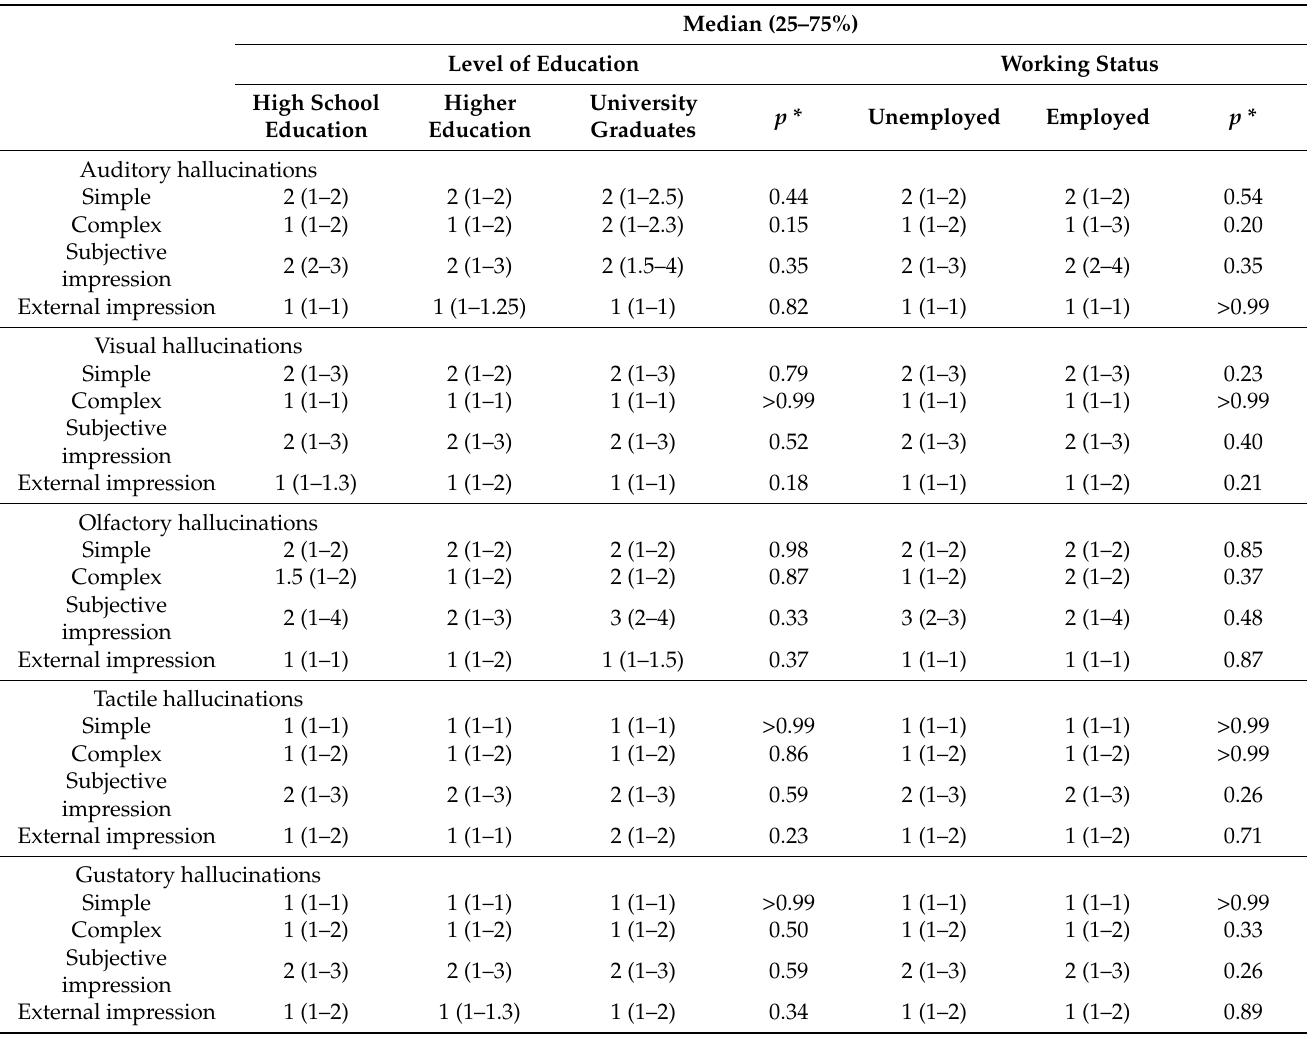
Table 6. Frequency of simple and complex, and according to the impression of subjective and external hallucinations in relation to the level of education and employment